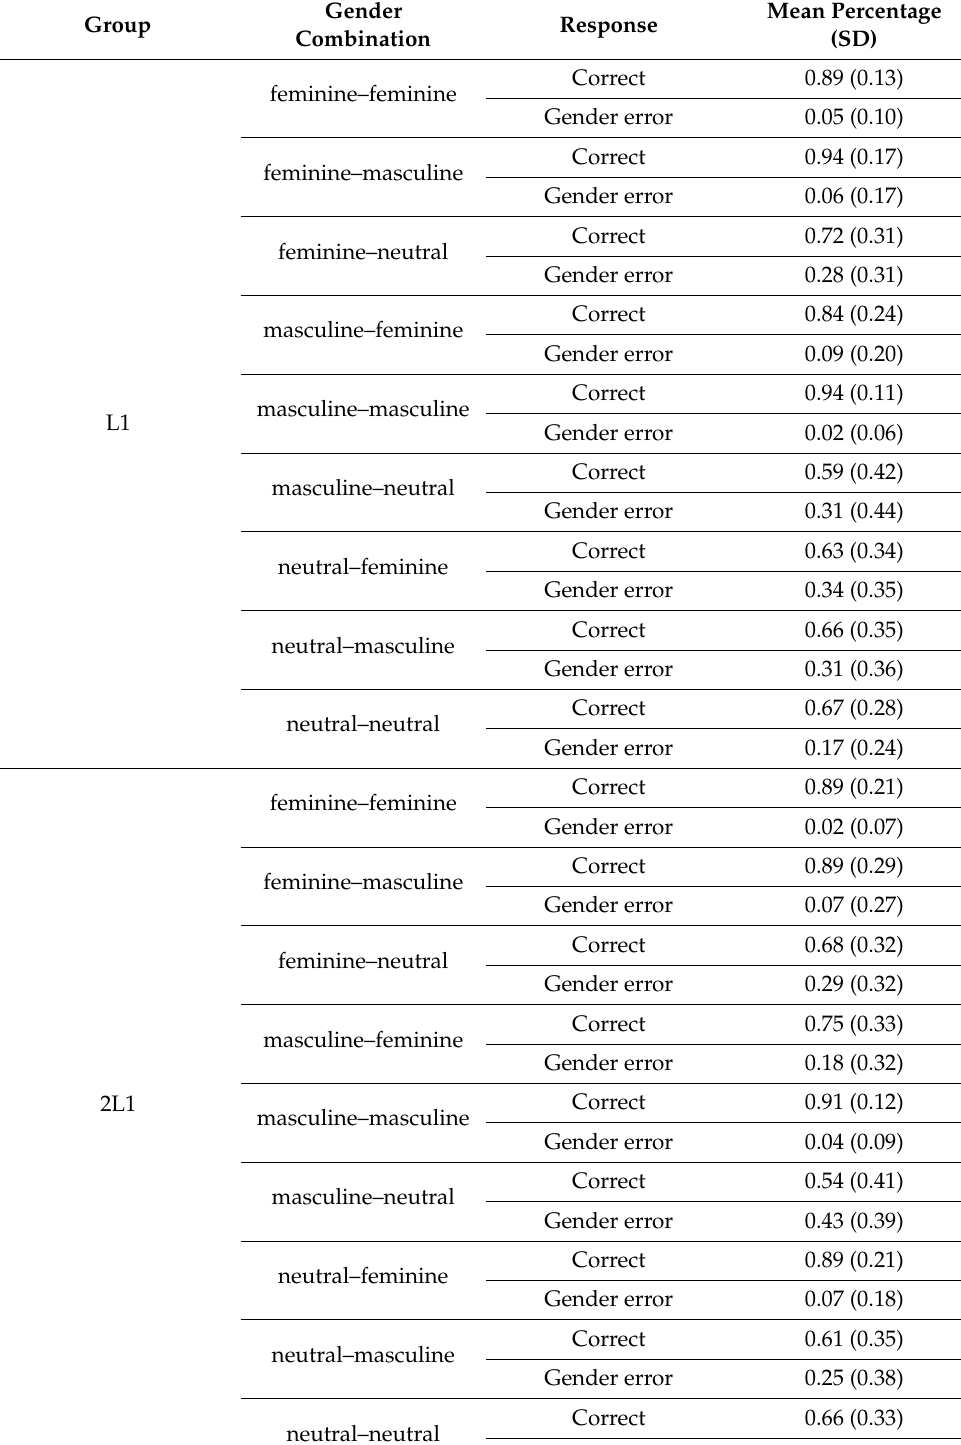
Table 10. Percentage and standard deviations of correct responses and responses with gender errors for each gender combination for the two groups. Feminine–feminine, masculine–masculine, neutral–neutral: both subject noun and clitic have the same gender (feminine, masculine and neutral, respectively), feminine–masculine: subject noun is feminine and clitic masculine, feminine–neutral: subject noun is feminine and clitic neutral, masculine–feminine: subject noun is masculine and clitic feminine, masculine–neutral: subject noun is masculine and clitic neutral, neutral–feminine: subject noun is neutral and clitic feminine, neutral–masculine: subject noun is neutral and clitic